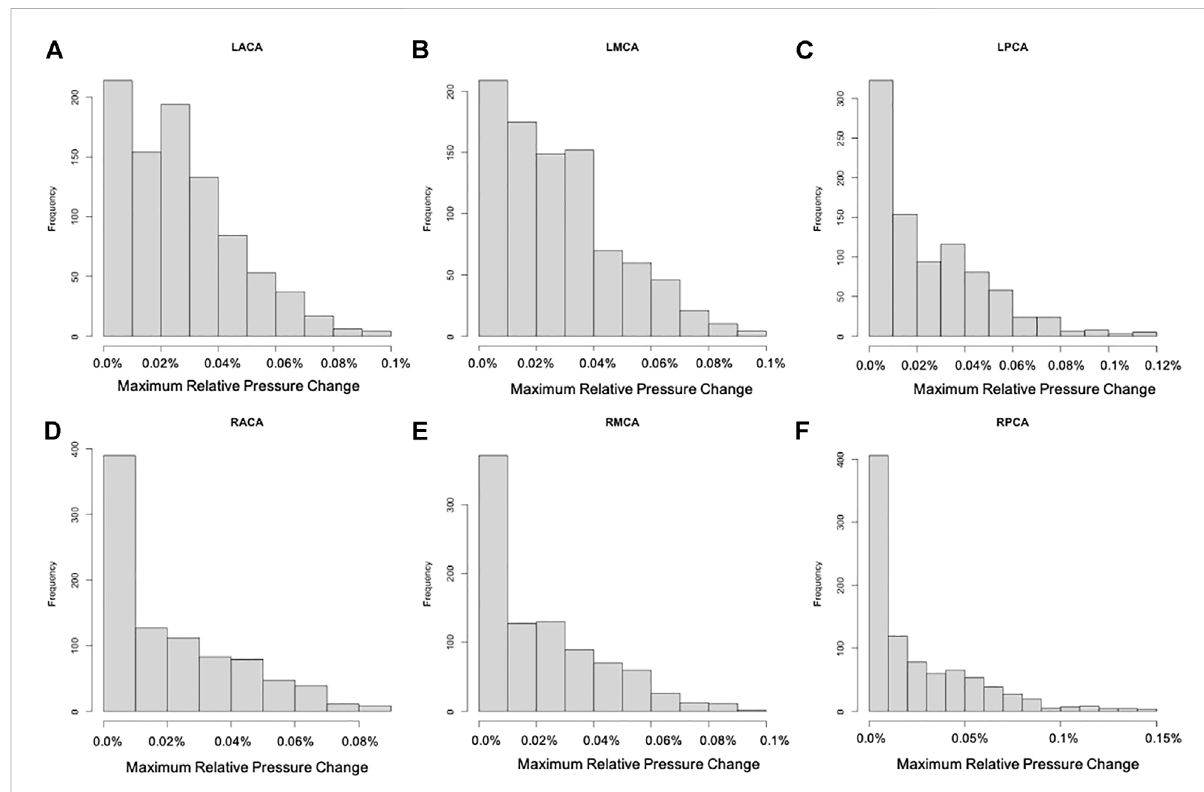
FIGURE 3 Histograms showing the frequency of maximum relative pressure change for each of the six cerebral arterial trees obtained for the different scenariosconsidered: (A) LACA, (B) LMCA, (C) LPCA, (D) RACA, (E) RMCA, (F) RPCA. Thesehistograms show thatthelargestchangewasbelow0.15% (maximum change occurred in the posterior cerebral artery